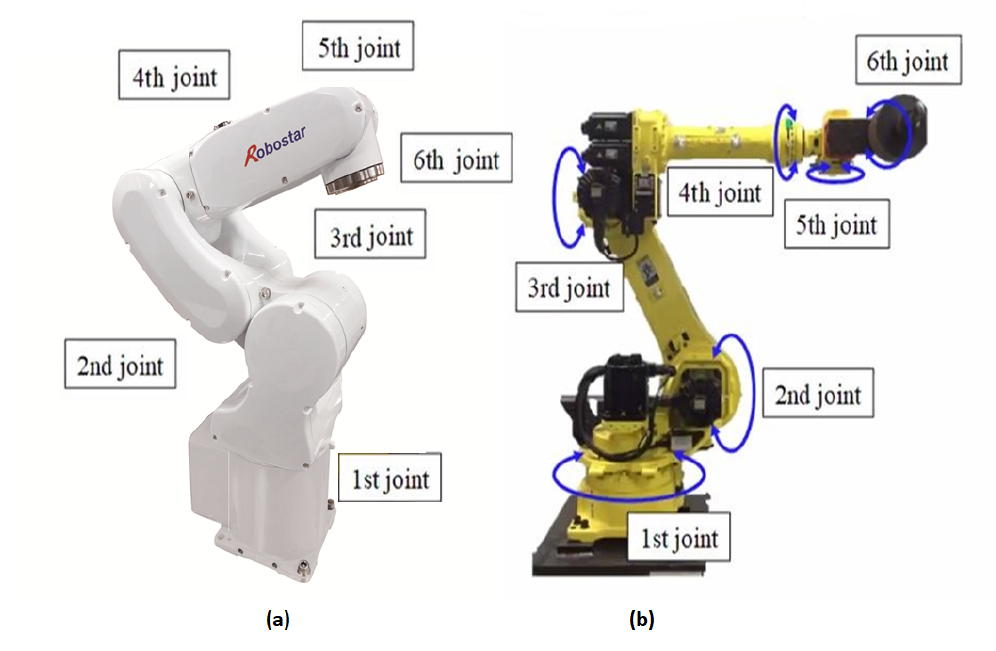
Figure 5. ( a ) Robostar R004 and ( b ) Hyundai Robot YS080.